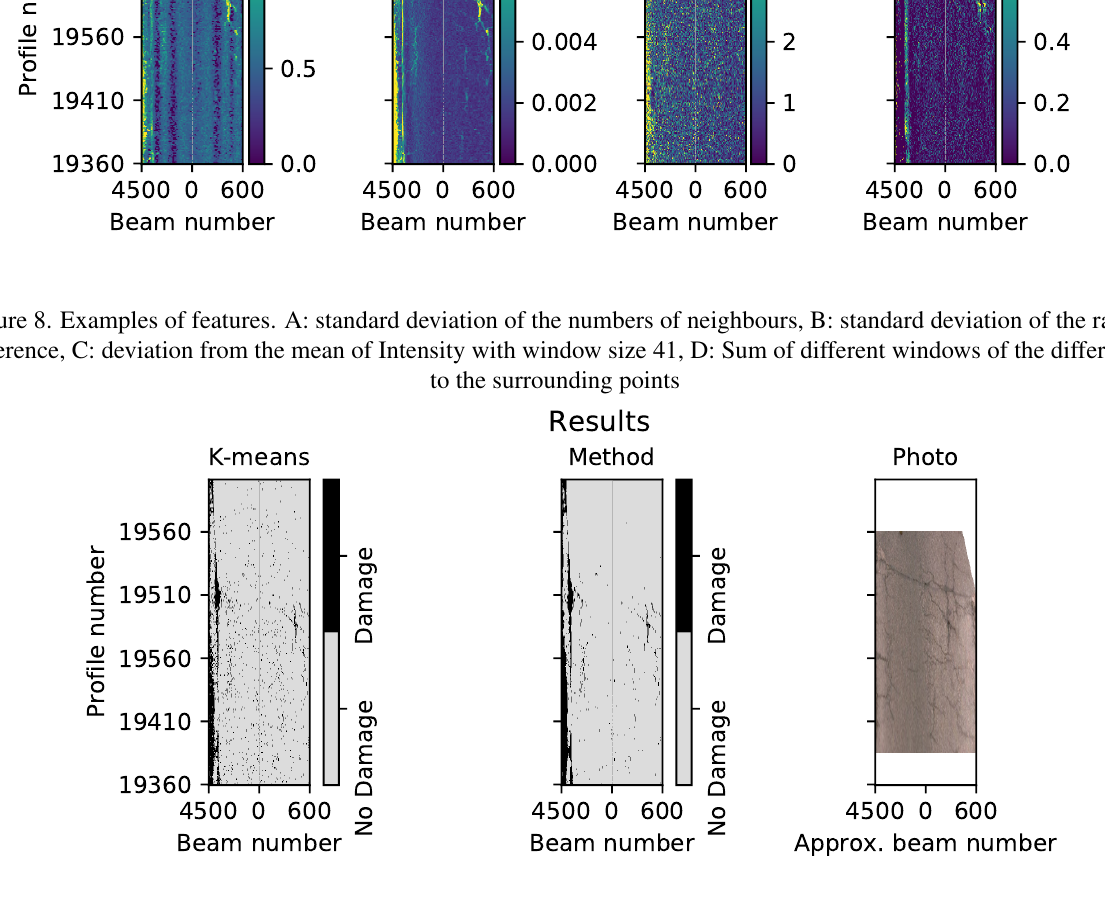
Figure 9. Results, left: the K mean classification, centre: the method classification, right: a photo of the